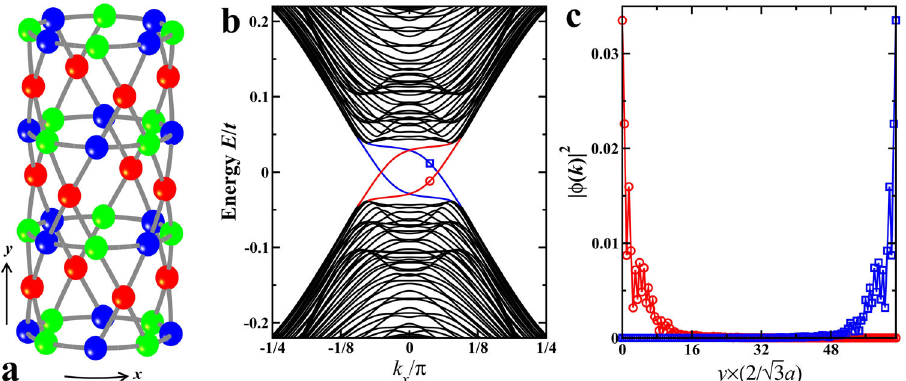
and red). L y =64 with 4×4 supercell. c Distribution along y -direction of the supercell averaged wavefunction amplitudes of the two in-gap CEMs indicated in b (red circle and blue square at k x =3 π /80), showing localization at the opposite edges illustrated in ( a